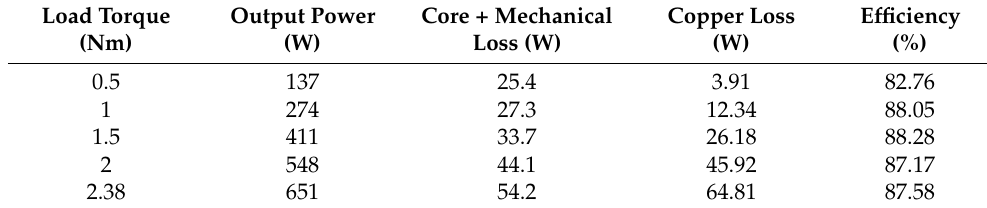
Table 5. Experiment results of the manufactured